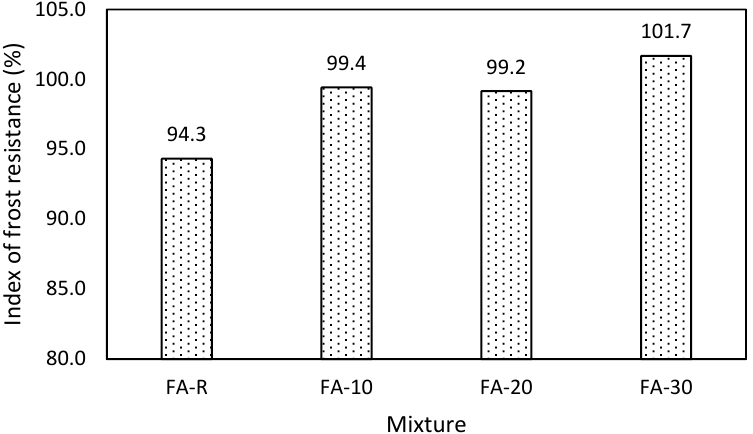
Figure 7. Index of frost resistance at the age of 90 days.